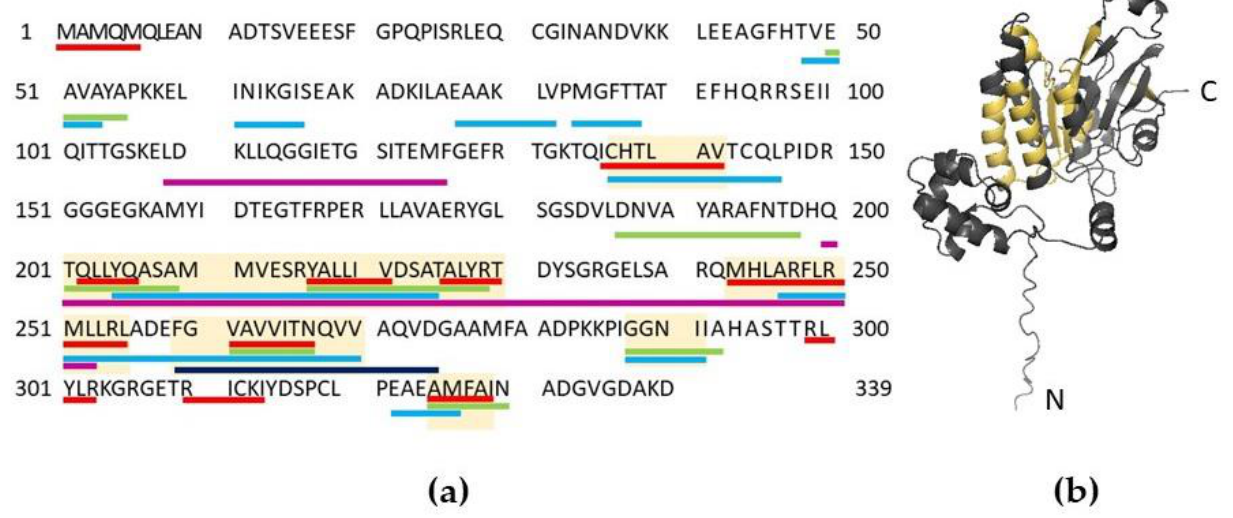
Figure 3. Representation of the amyloidogenic regions in RAD51. ( a ) Analysis performed by FoldAmyloid (red), Waltz (green), AGGRESCAN (light blue), ArchCandy (magenta) and PASTA 2.0 (dark blue). Light yellow boxes represent amyloidogenic regions predicted by at least two algorithms that are ≥5 a.a. long. ( b ) The 3D model of the RAD51 protein was generated using AlphaFold2 [50] and visualized with PyMol (pymol.org). The amyloidogenic regions predicted by at least two algorithms ( ≥5 a.a. long ) are shown in yellow.